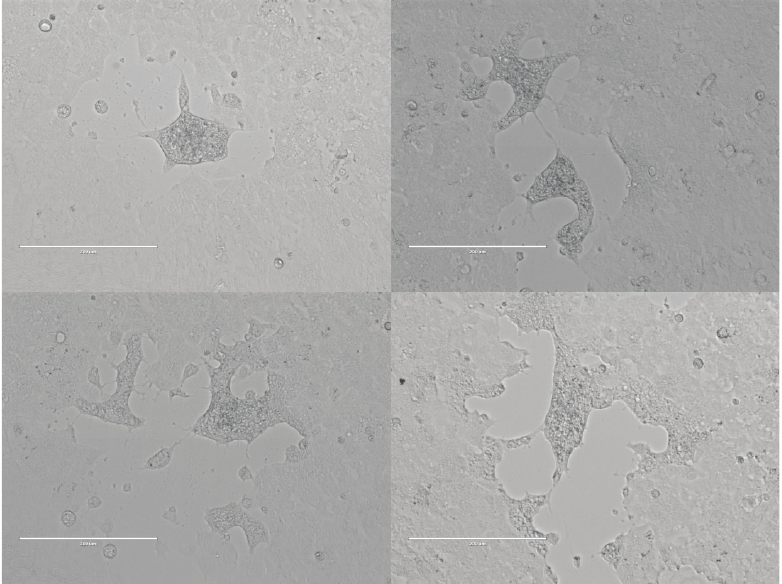
Figure 2. Cytopathic effects in the form of syncytia formation cause by MAHL (Mahlapitsi virus) in Vero E6 cells, from four days post infection onwards.